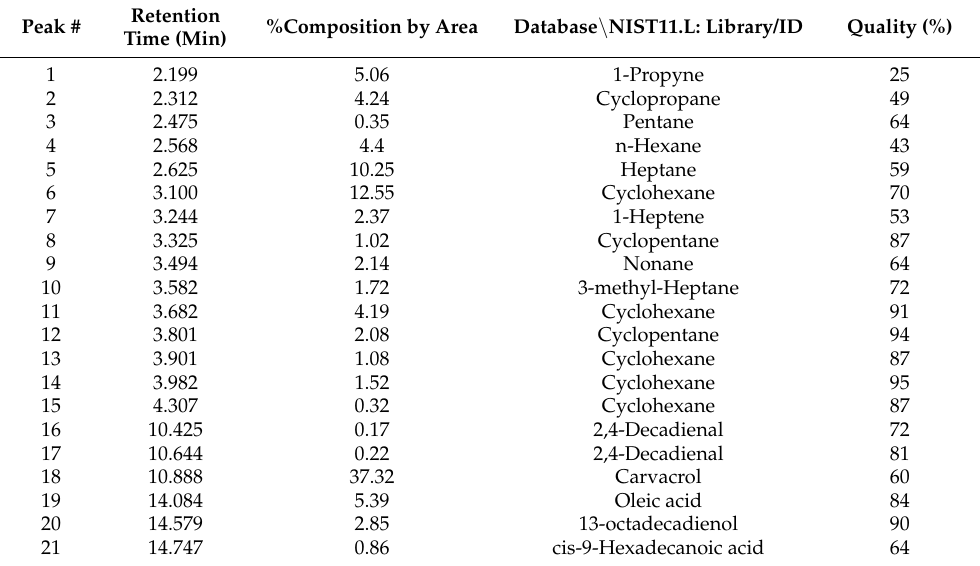
Figure 7. Ferric reducing power. SEO—seed essential oil. Table 4. GC-MS analysis of 2% carvacrol solution after thermal treatment for 15 min.